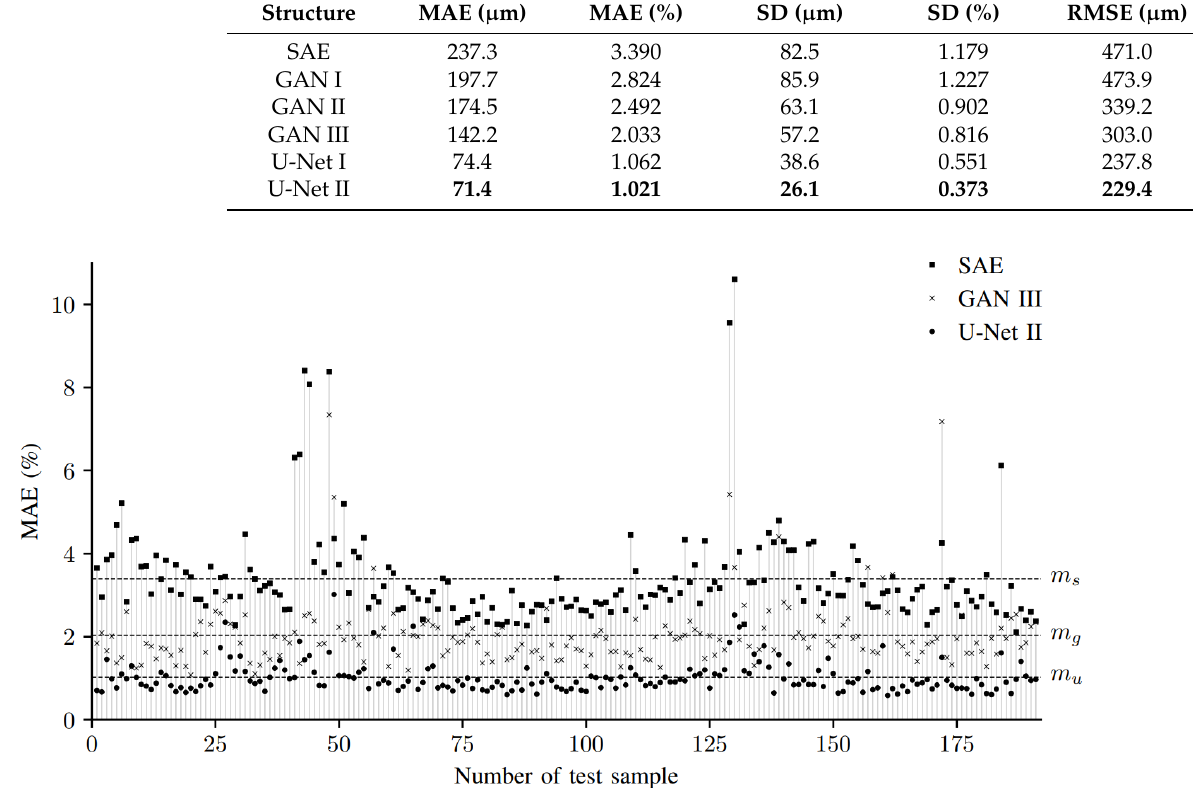
Figure 4. MAE of the 191 test samples. The MAE of three methods over the test samples is shown. m s = 3.390% is the mean MAE of the SAE, m g = 2.033% that of the WGAN with L2 norm and m u = 1.021% that of the SDU-Net (Table